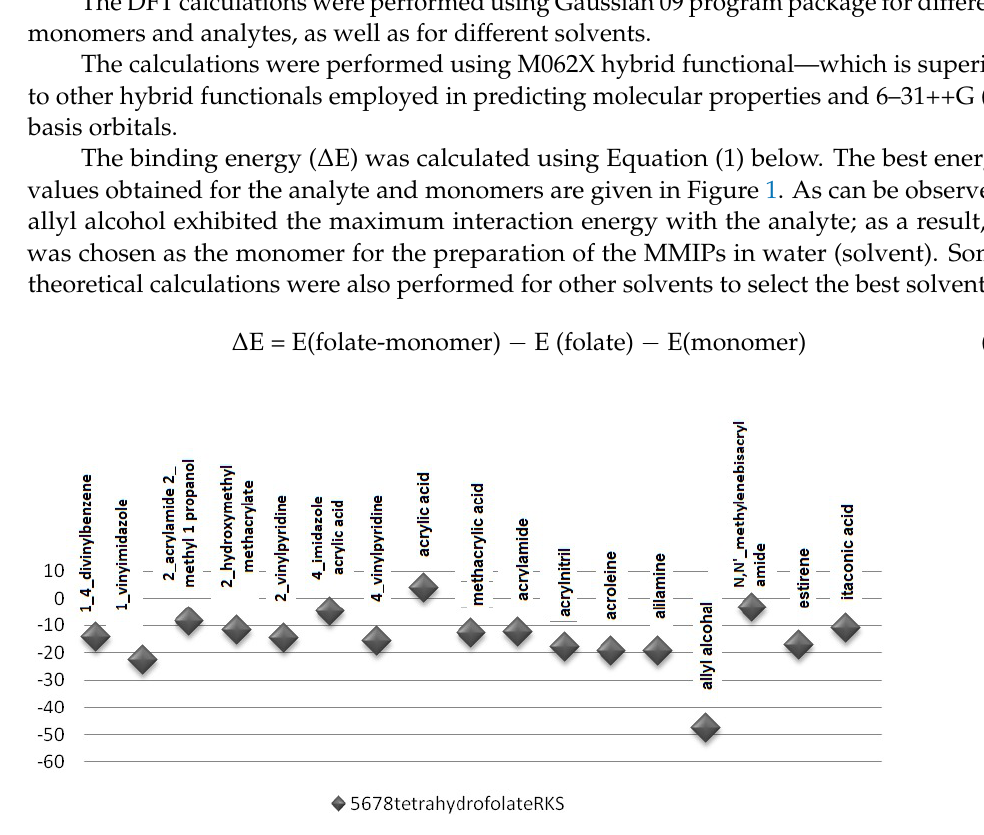
Figure 1. Monomers used for semi-empirical computational simulations.